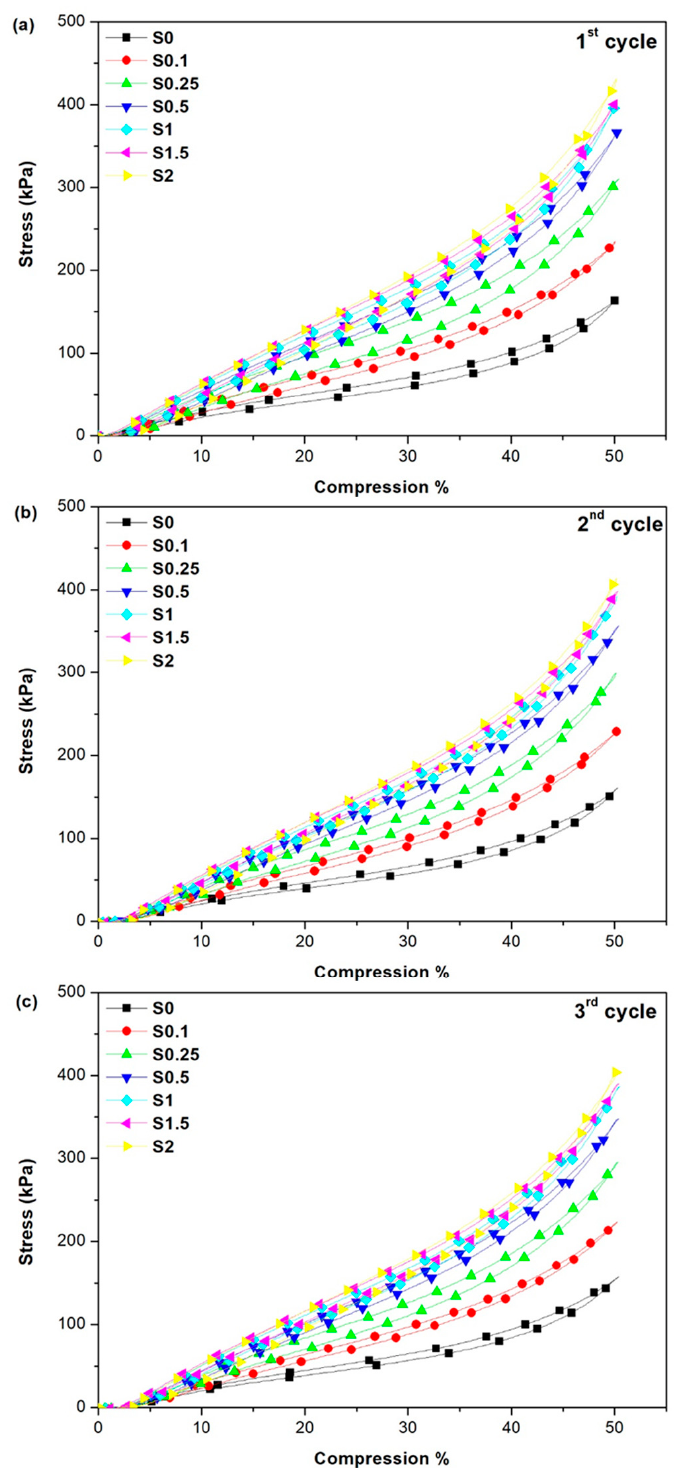
Figure 7. The effect of CNT/GNS hybrid content on the stress − strain behavior of the NR/CNT/GNS foams: ( a ) first cycle, ( b ) second cycle, and ( c ) third cycle .